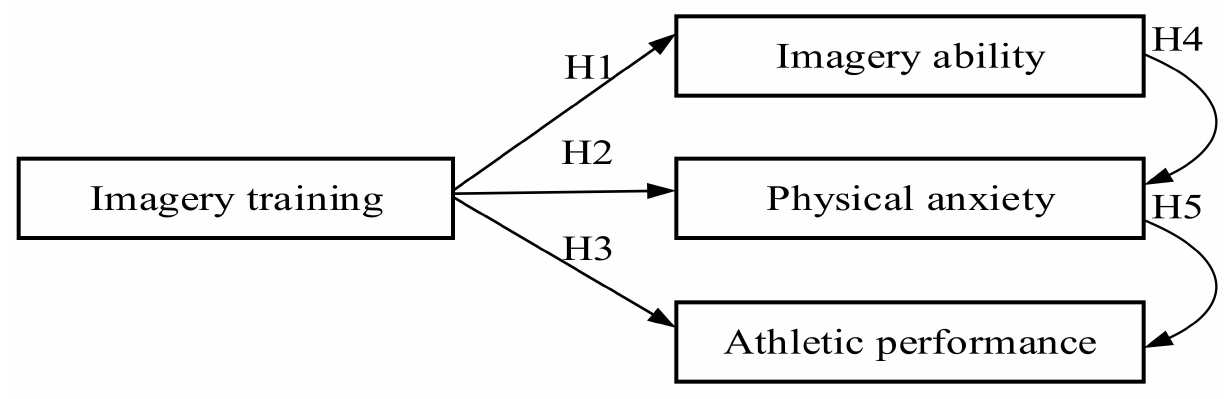
Figure 1. Research